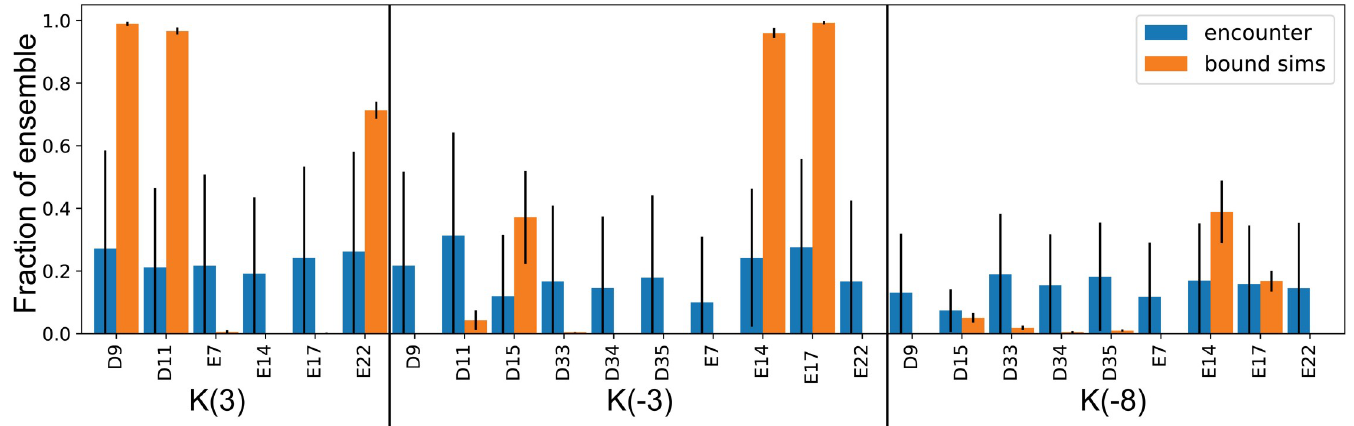
Fig 9. Long-range electrostatic interactions are non-specific in the encounter complex and specific in the bound simulations. Frequency of particular long-range electrostatic interactions in the ArkA encounter complex (blue bars on the left) and ArkA bound simulations (orange bars on the right). The large labels indicate the ArkA residue involved in the long-range electrostatic interaction and the small labels indicate the AbpSH3 residue. Error bars represent the standard deviation between independent simulations.